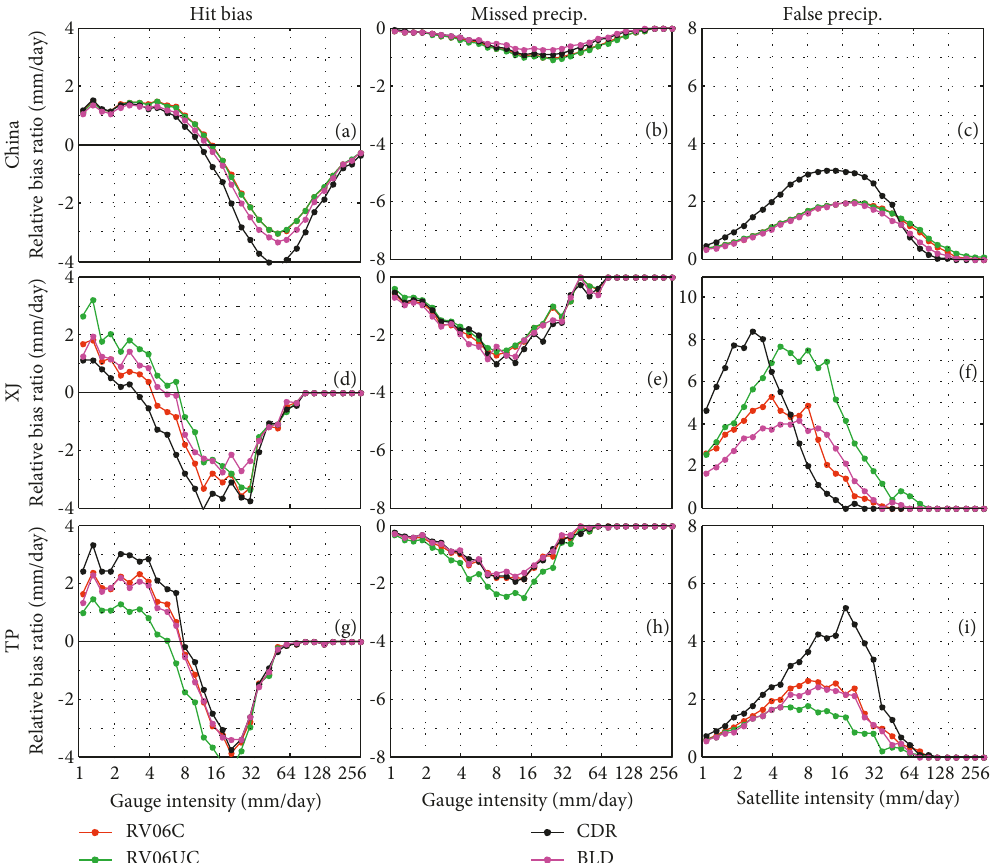
Figure 18: Intensity distribution of relative bias ratio for the error components of RV06C, RV06UC, CDR, and BLD during summers for the period from March 2014 to June 2018 over China and XJ and TP